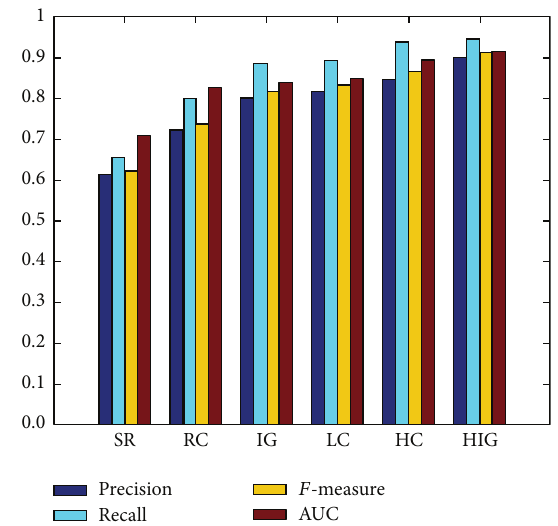
Figure 5: Statistical comparson results (Precision, Recall, 𝐹 - measure,andAUC)ofdifferentvisualsaliencydetectionalgorithms: HC [17], LC [11], RC [17], SR [12], IG [14], and HIG in the